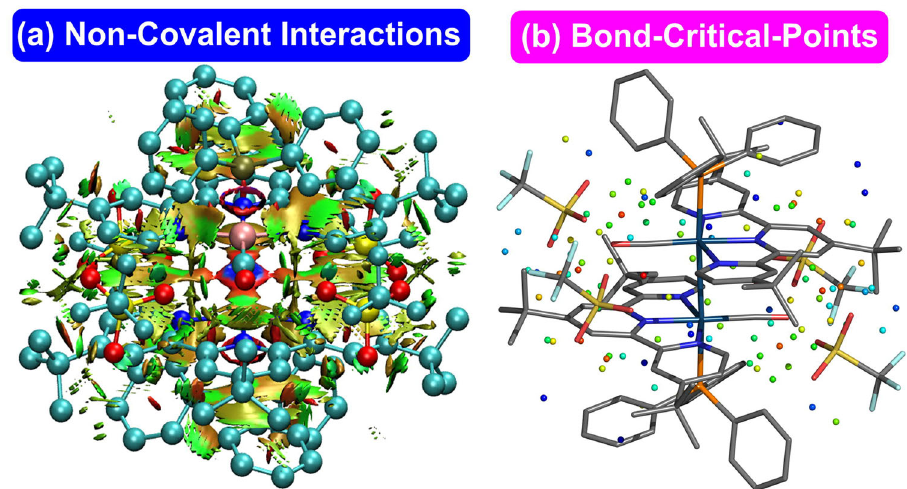
Fig. 5 Non-covalent interactions of 1. a Non-covalent interactions (NCIs) analysis (red: strong repulsion; green: weak attraction; blue: strong attraction) and b the QTAIM analysis (Bond-Critical-Points (BCPs) in a sphere form; red: highest ρ ; blue lowest ρ ) in 1 based on the SMD M06-L//M06-L